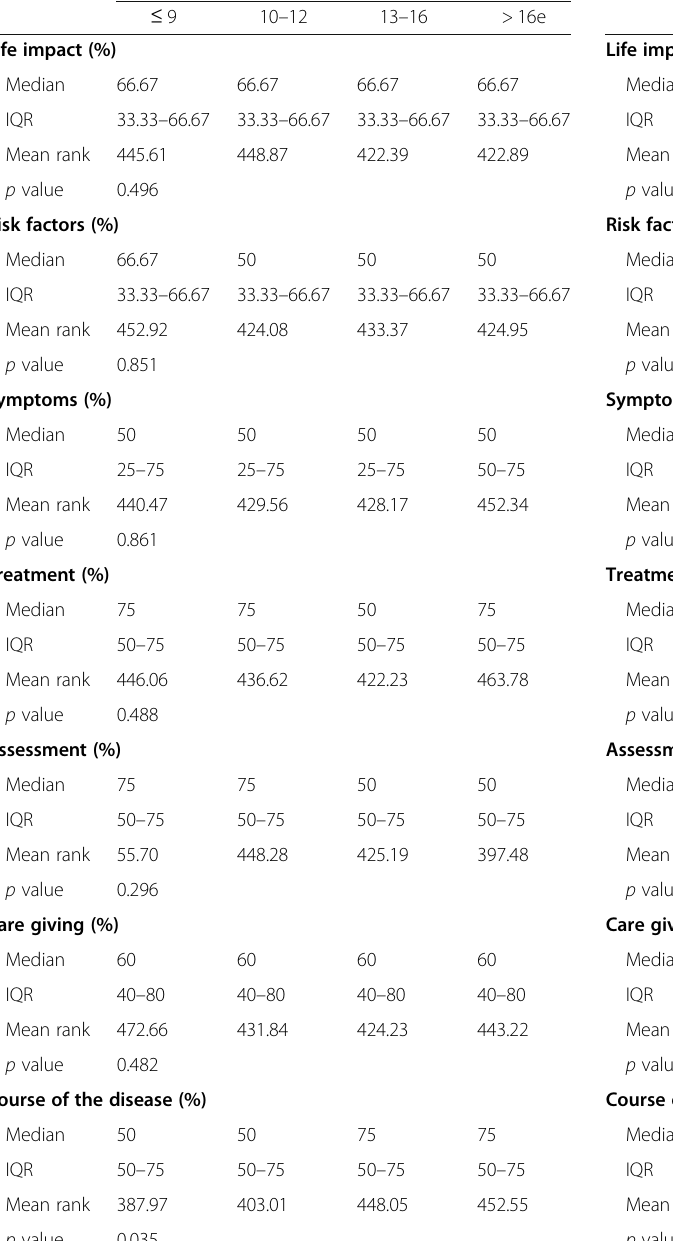
Table 7 Knowledge of different aspects of Alzheimer ’ s